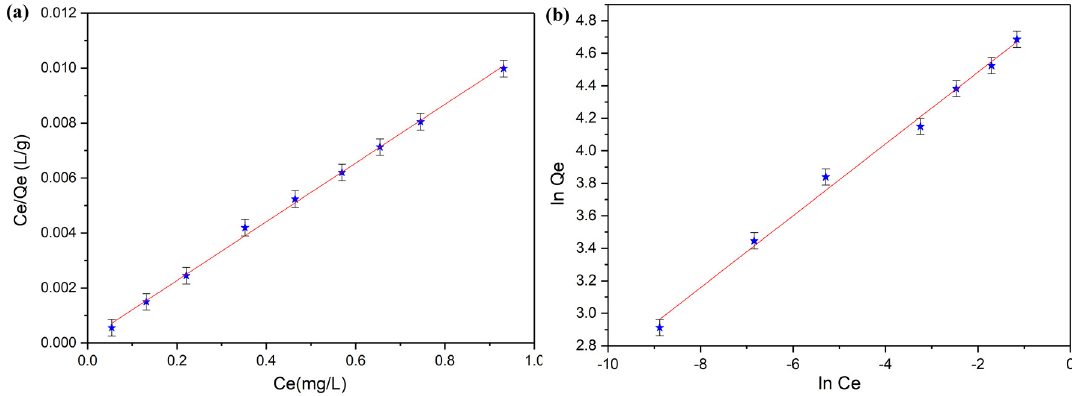
Figure 8. Langmuir ( a ) and Freundlich ( b ) graphical linearized equations for the adsorption of strontium ions on HAp nanoparticles.